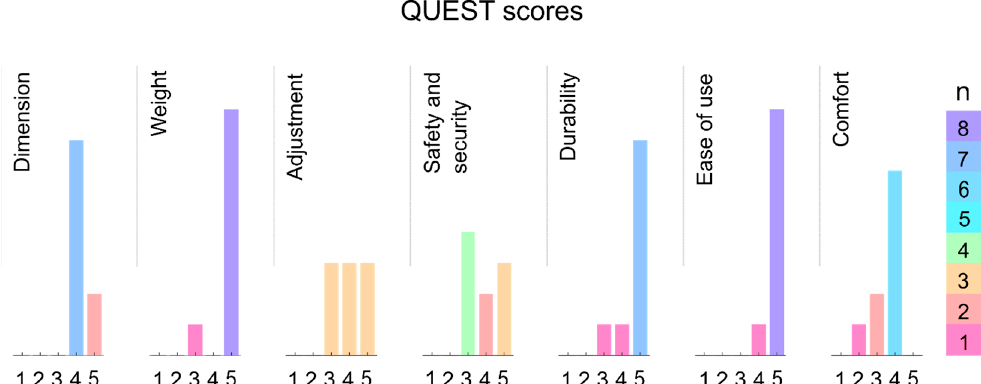
Figure 7. The distribution of the Quebec User Evaluation of Satisfaction with assistive Technology (QUEST) questionnaire responses as filled out by the subgroup that had worn the instrumented knee brace over the course of a day; n = number of responses.